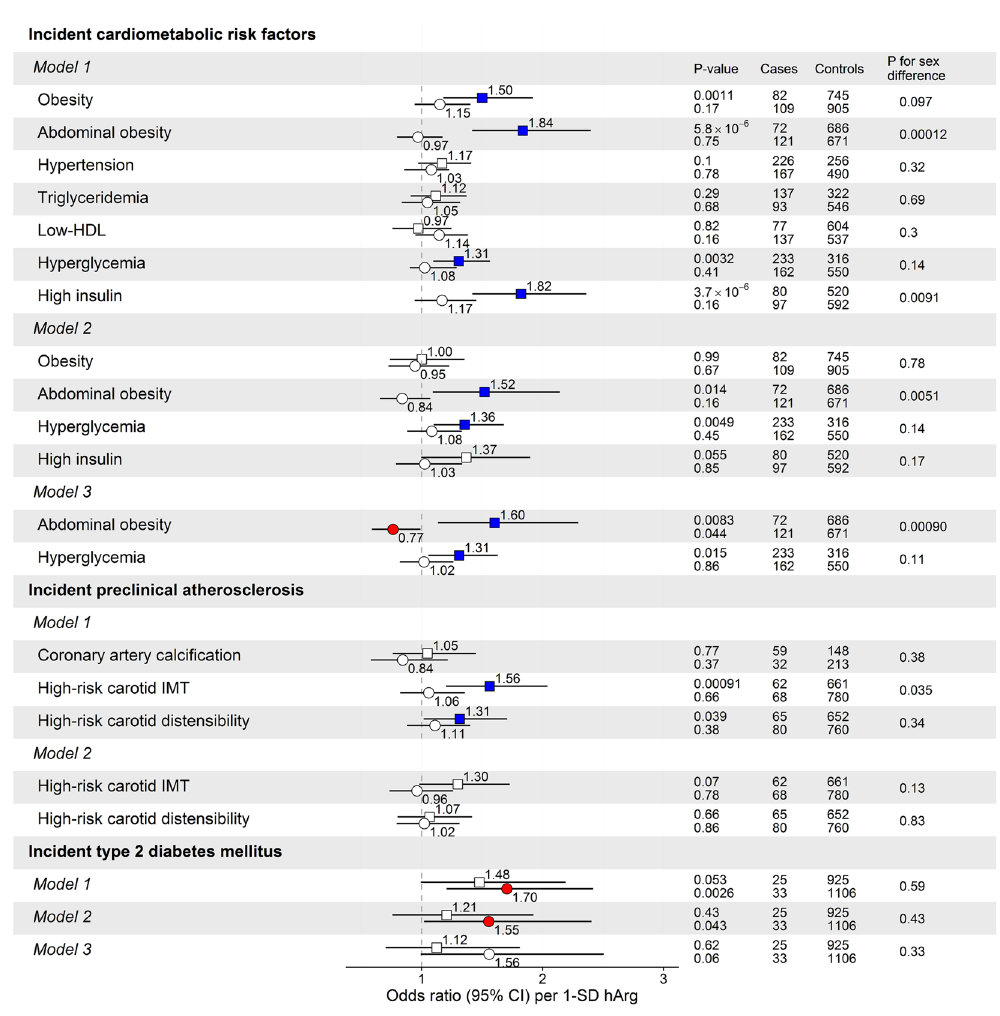
blood glucose is likely seen at much higher concentrations of hArg than what is normally present in the blood, in line with the tightly regulated glucose homeostasis in humans without overt T2DM. A 16-week oral hArg supple- mentation resulted in a 6-fold increase in plasma hArg, as well as increased insulin secretion and reduced blood glucose in mice on a high-fat diet but not in mice on a normal diet 14 . This contrasts with a moderate increase in blood glucose in the RCT, probably due to the differences in glucose metabolism between mice and humans. In concordance with several previous studies 8, 13 , we observed an independent negative association between daily smoking and circulating hArg levels, while the molecular underpinnings of this association remain elusive. In contrast to some studies on older adults from general and patient populations 6, 13 , we observed no associations between baseline hArg and incident arterial hypertension during a 10-year follow-up, or baseline diastolic or systolic blood pressure in young adults. We were unable to study the causality of lifelong exposure to hArg on blood pressure due to the lack of publicly available complete summary statistics on the hArg-associated SNPs, and further MR studies are thus warranted to address whether there is any causal effect of circulating hArg on blood pressure in humans. However, the RCT on hArg supplementation in young volunteers did not detect any differences in diastolic or systolic blood pressure between hArg and placebo after a 4-week supplementation 15 . Baseline hArg was positively associated with incident T2DM especially in women, although the association was attenuated after adjusting for cardiometabolic risk factors and the use of oral contraceptives. A causal effect of hArg on T2DM was absent, suggesting that lifelong exposure to higher circulating hArg levels does not increase